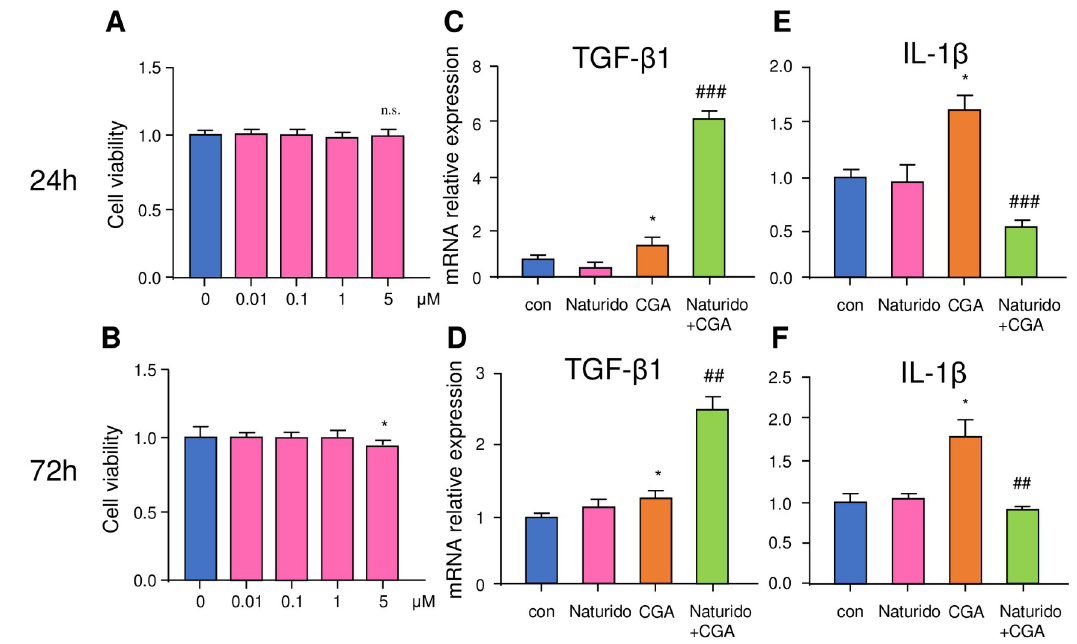
Fig 4. Effects of Naturido on the expression of transforming growth factor (TGF)- β and interleukin (IL)-1 β . (A) and ( B), Relationship between incubation time (a, 24 h; b, 72 h) and cell viability. (C) and ( D), Effects of Naturido (1 μ M), chromogranin A (CGA), or combined Naturido and CGA treatment for 24 h or 72 h on TGF- β expression. ( E) and ( F), Effects of Naturido (1 μ M), chromogranin A (CGA), or combined Naturido and CGA treatment for 24 h or 72 h on IL-1 β expression. All values are expressed as means ± SEMs. � / # P < 0.05, �� /## P < 0.01, ��� /### P < 0.001 vs the control ( � ) or CGA ( # ) group (Turkey-Kramer test using the GraphPad Prism software